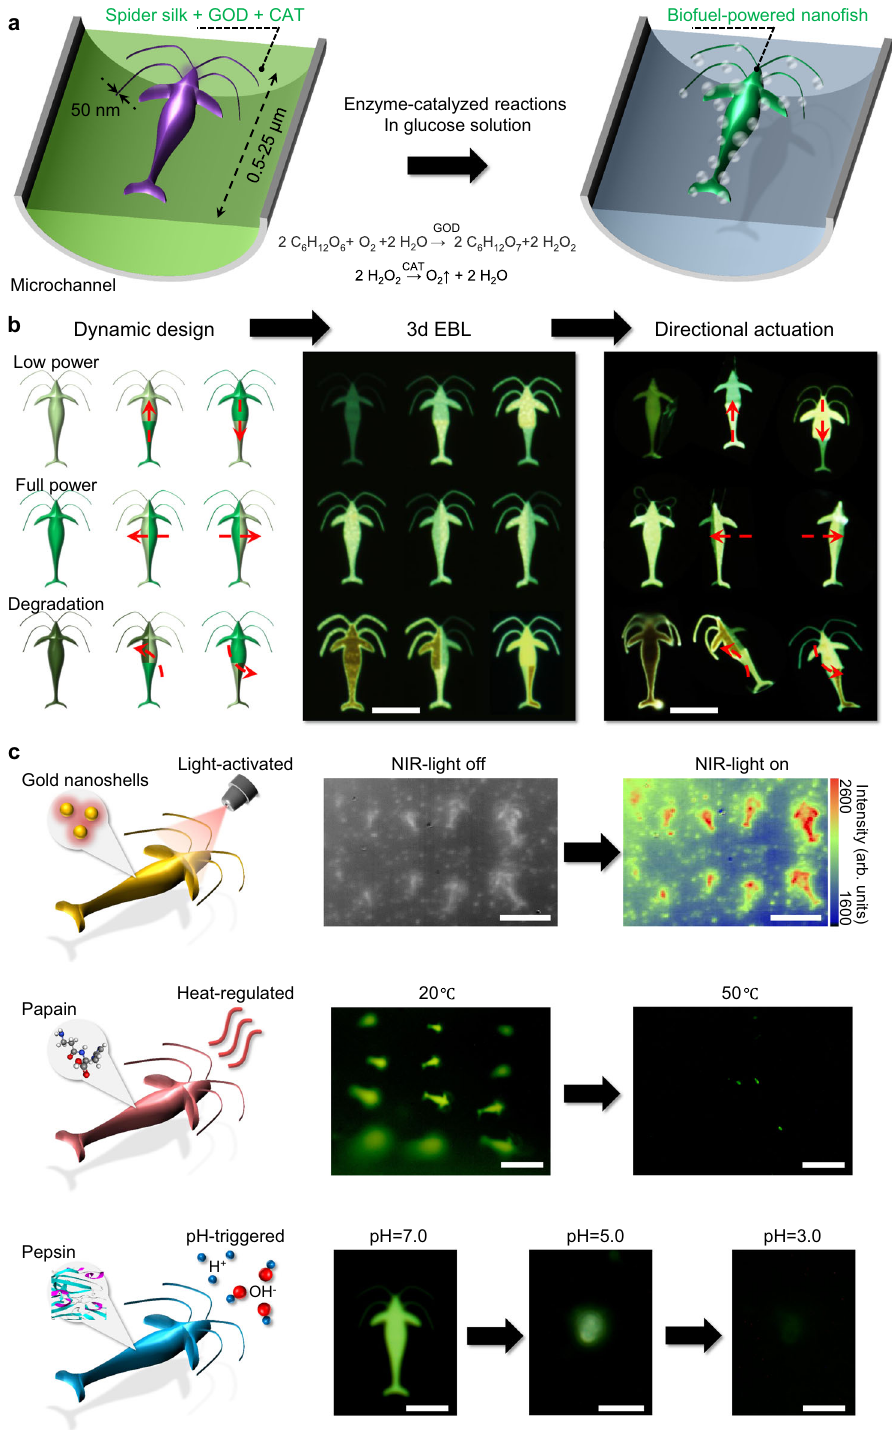
Fig. 4 Biofuel-powered, enzyme-assisted spider silk nano fi shes fabricated using 3d EBL. a Diagram of the enzyme-assisted glucose-powered nano fi shes manufactured in the microchannel. b Dynamic design, 3d EBL printed, and the directional actuation of the nano fi shes. Scale bars in ( b ), fl uorescence microscope photographs (right 2 images), 10 μ m. c Near-infrared (NIR) light-activated, temperature, and pH-triggered dissolution of the ambient sensing nano fi shes for the controllable payload release and device lifetime. Scale bar in ( c ), NIR microscope photographs ( fi rst row), 20 μ m; fl uorescence microscope photographs, 20 μ m (second row), and 5 μ m (third row),